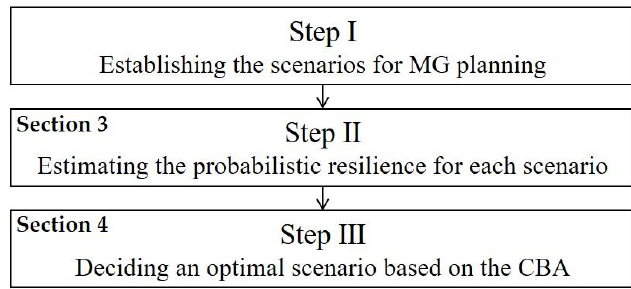
Figure 1. MG planning framework.